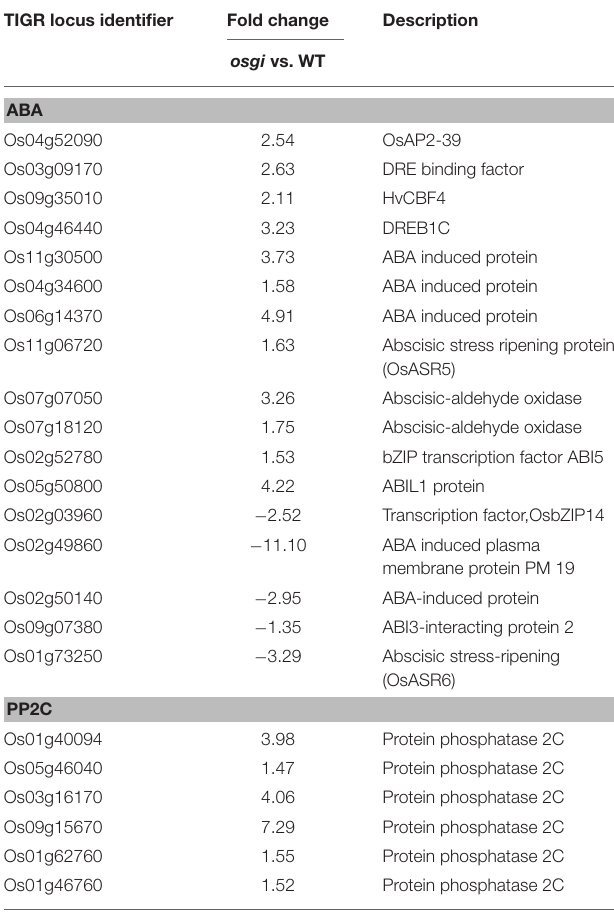
protein phosphatase 2C (PP2C) genes in subfamily A ( Table 1 ;